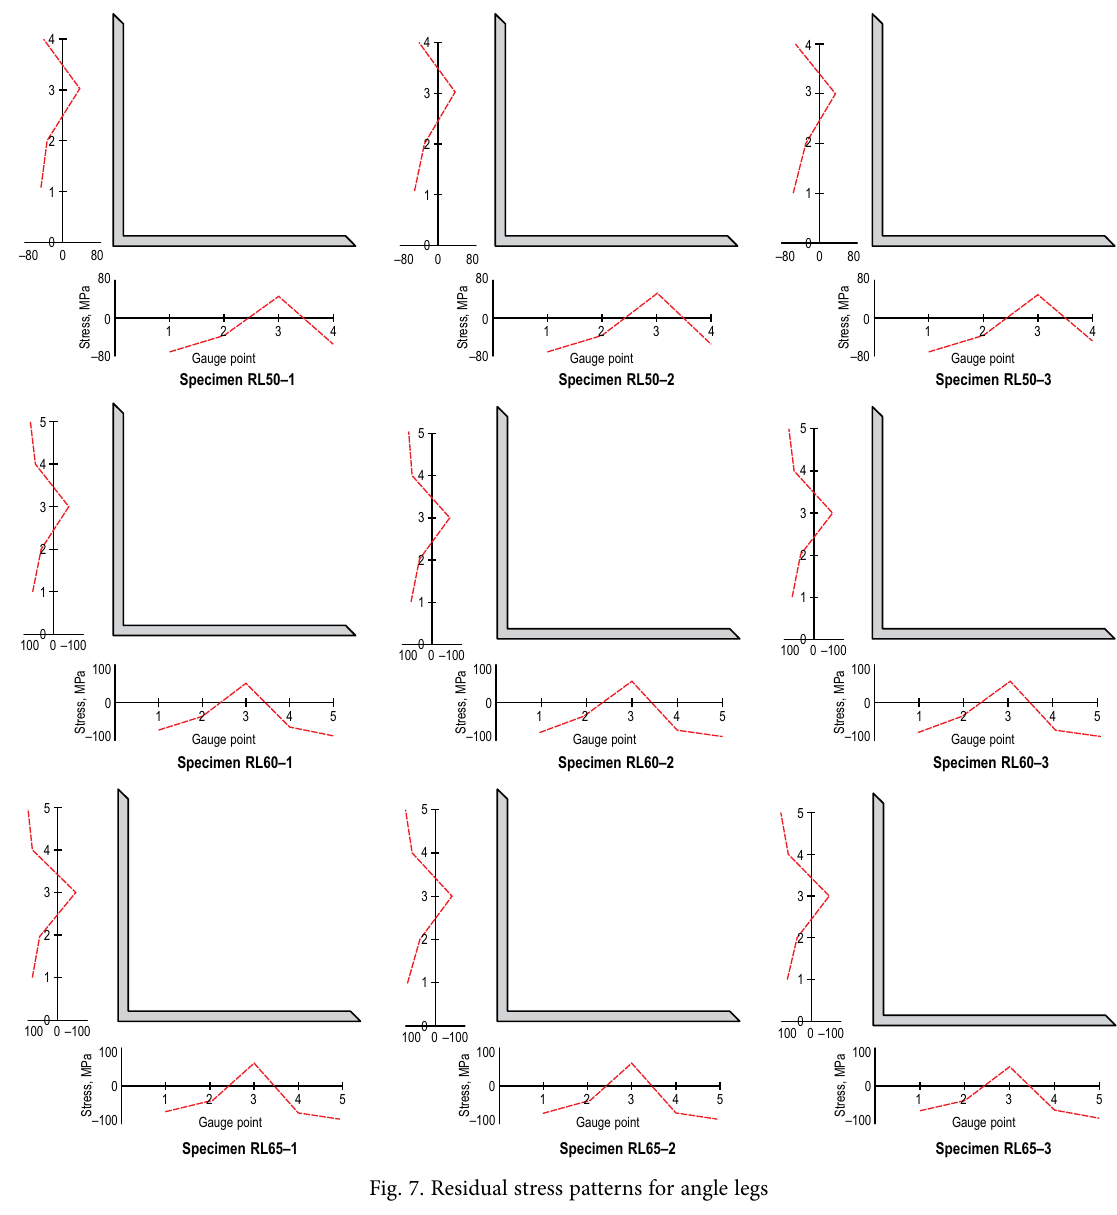
Fig. 7. Residual stress patterns for angle legs